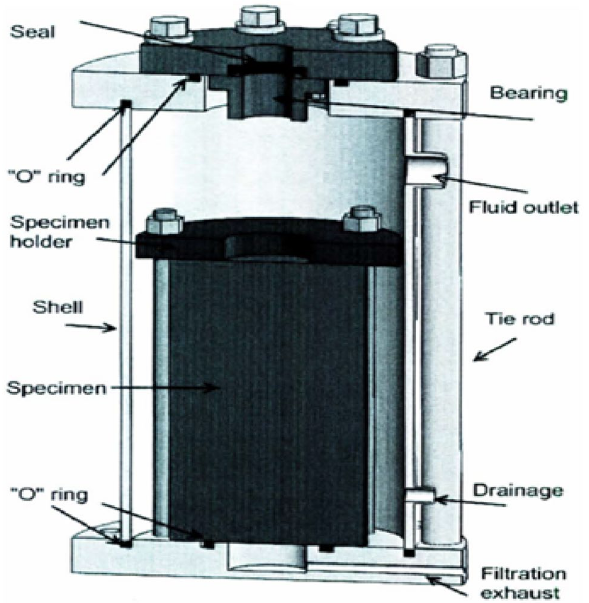
Fig. 2 Sectional view of a schematic drawing of a pressure cell (Source: Khorshidan